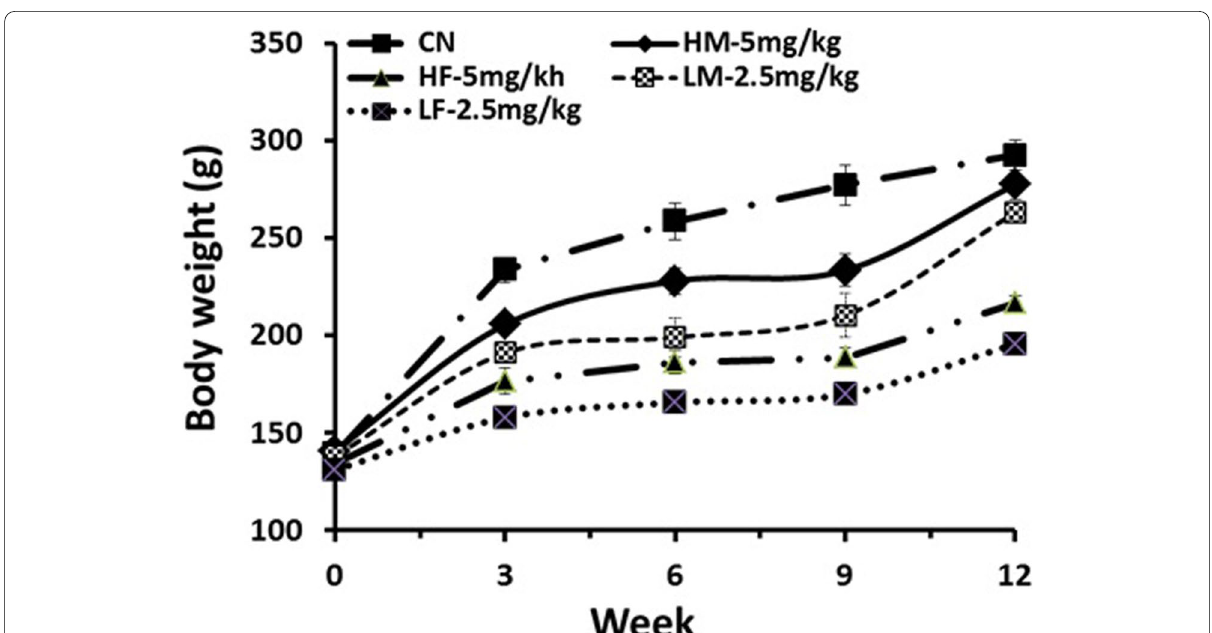
Fig. 2 Body weight changes in rats exposed orally to different doses of Mystomate4 ® for 12 weeks compared to control. CN male, LF